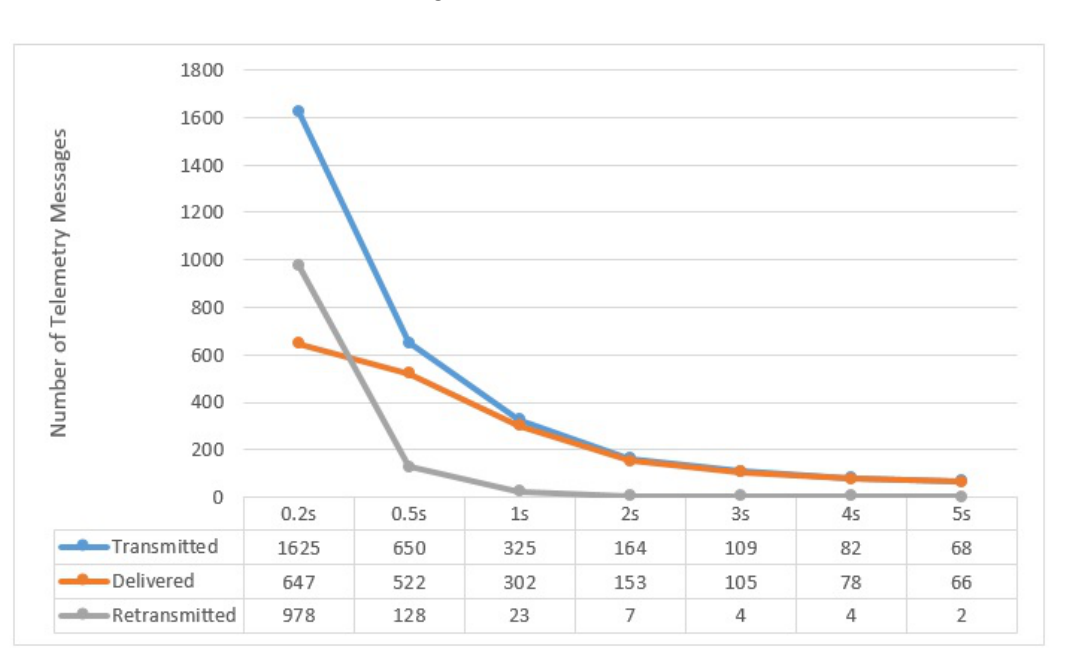
Figure 13. UAV to BS Communication at 5 m/s with respect to different Flush Back Periods.